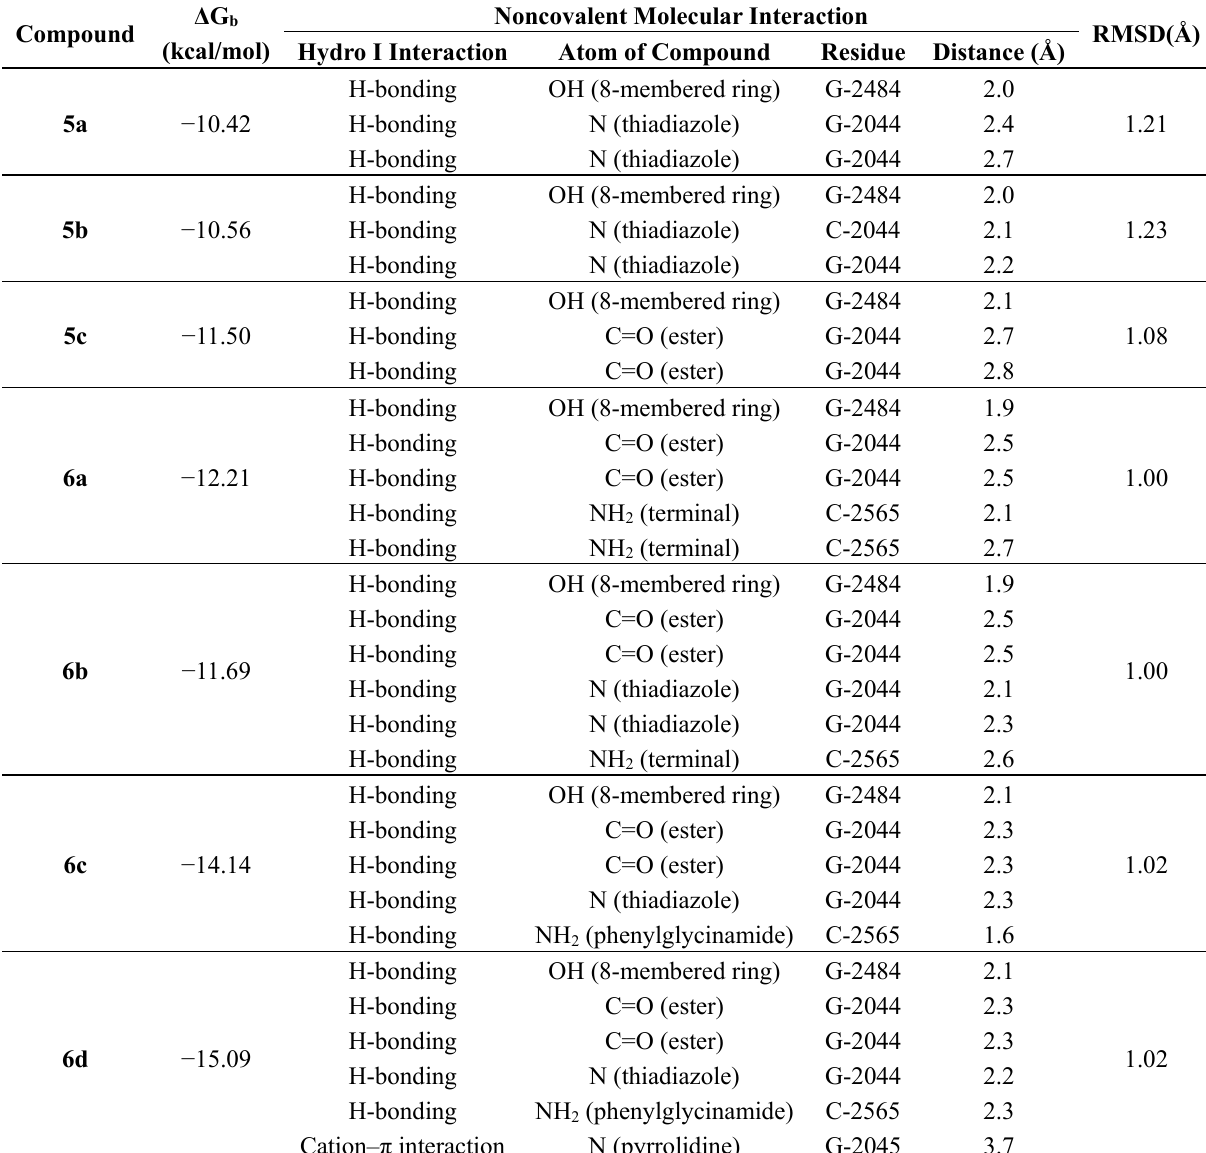
Table 3. Binding free energy, number of noncovalent molecular interactions and RMSD.